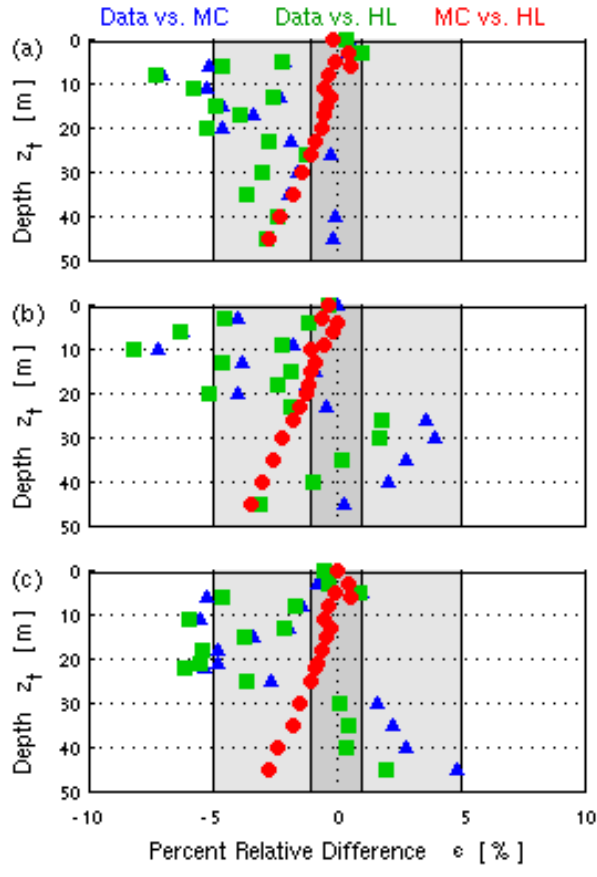
Fig. 3. Percent relative differences of E d mean values between mea- sured data, our Monte Carlo (MC) model and HydroLight (HL); Figure 3. Percent relative differences of E (a) 30 October 2009; (b) 3 November 2009; (c) 16 November 2009, the related conditions are specified in Table Monte Carlo (MC) model and HydroLight (HL); (a) 30 Oct. 2009; (b) 3 Nov. 2009; (c) 16 Nov. 4 2009, the related conditions are specified in Table 1. 5